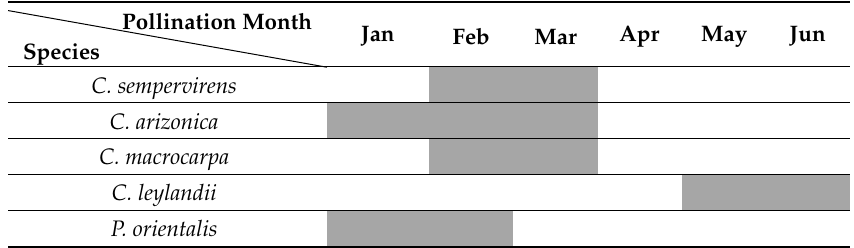
Table 2. Pollination periods for all the considered species in this